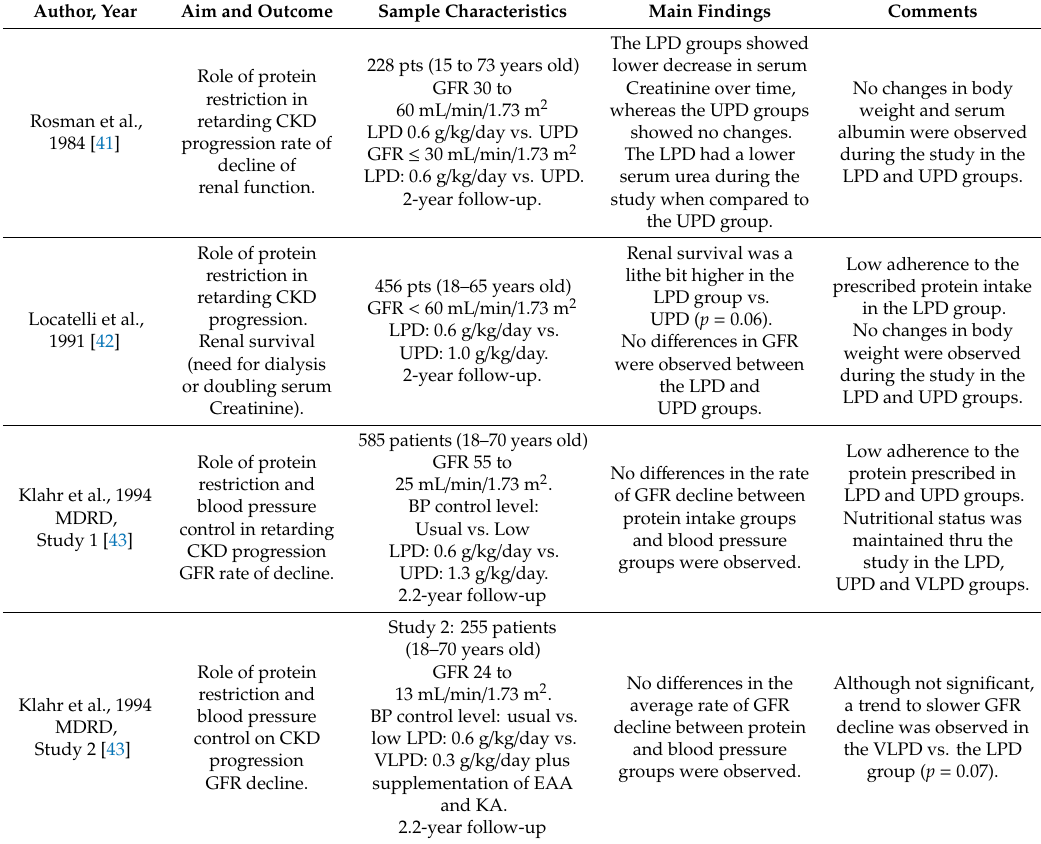
Table 2. Summary of the randomized controlled clinical trials, including more than 200 patients with follow-up > 6 months, investigating the role of protein restricted diets in patients with chronic kidney disease of stages 3 to 5 (not on